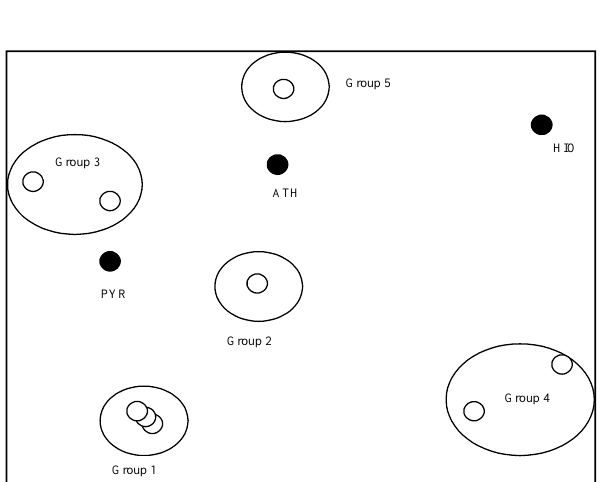
Fig. 12. Graphic of HIO monitoring site for three different condi- Fig.12. Graphic of HIO Monitoring site three different conditions of GFdiff. tions of GFdiff. Figure 13. Grouping based on the area of 12 earthquakes in the period of January 1, to June 2 Fig. 13. Grouping based on the area of 12 EQs in the period of 1 January to 30 June